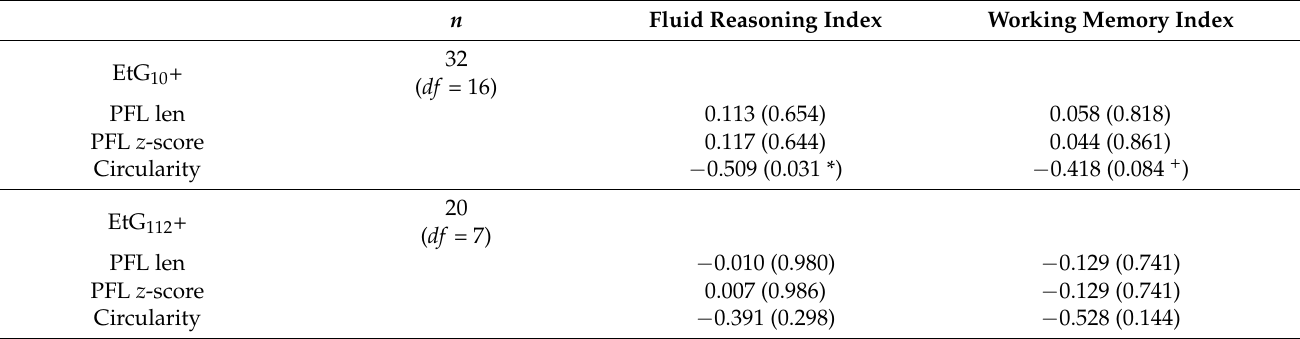
Table 5. Partial correlations (r p) of child PFL and lip circularity with the fluid reasoning and working memory index within the affected EtG+ groups.